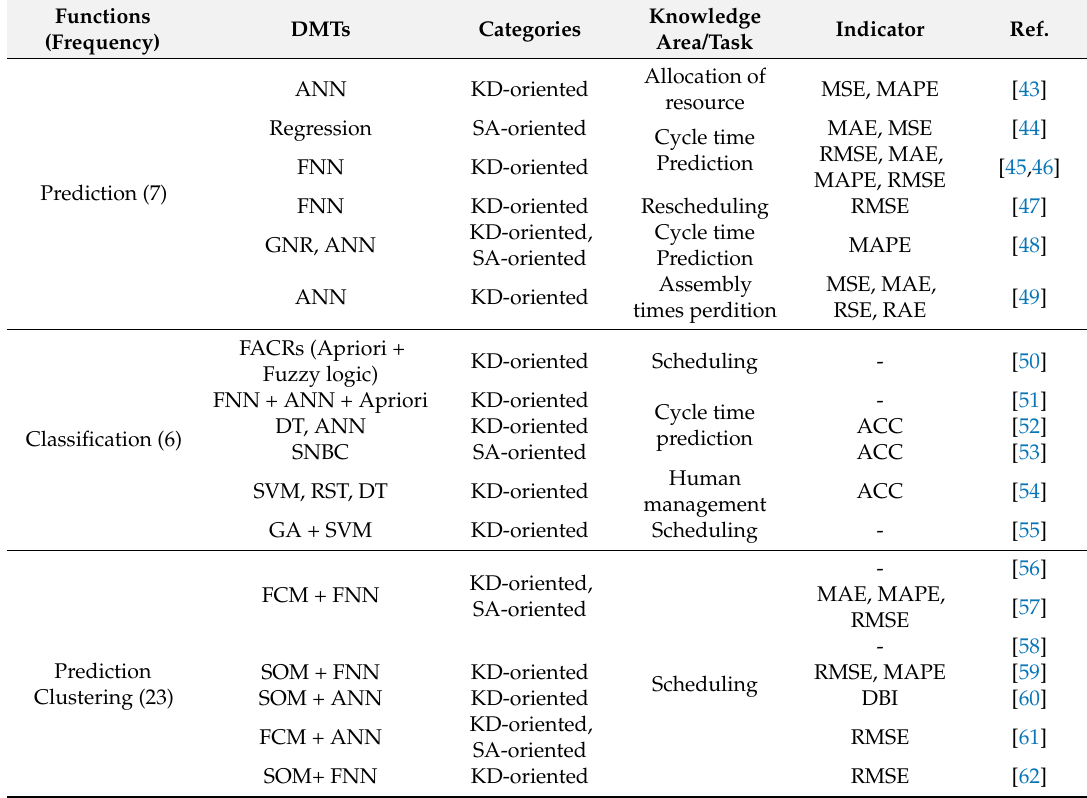
Table 10. DM with Big Data application for production management and